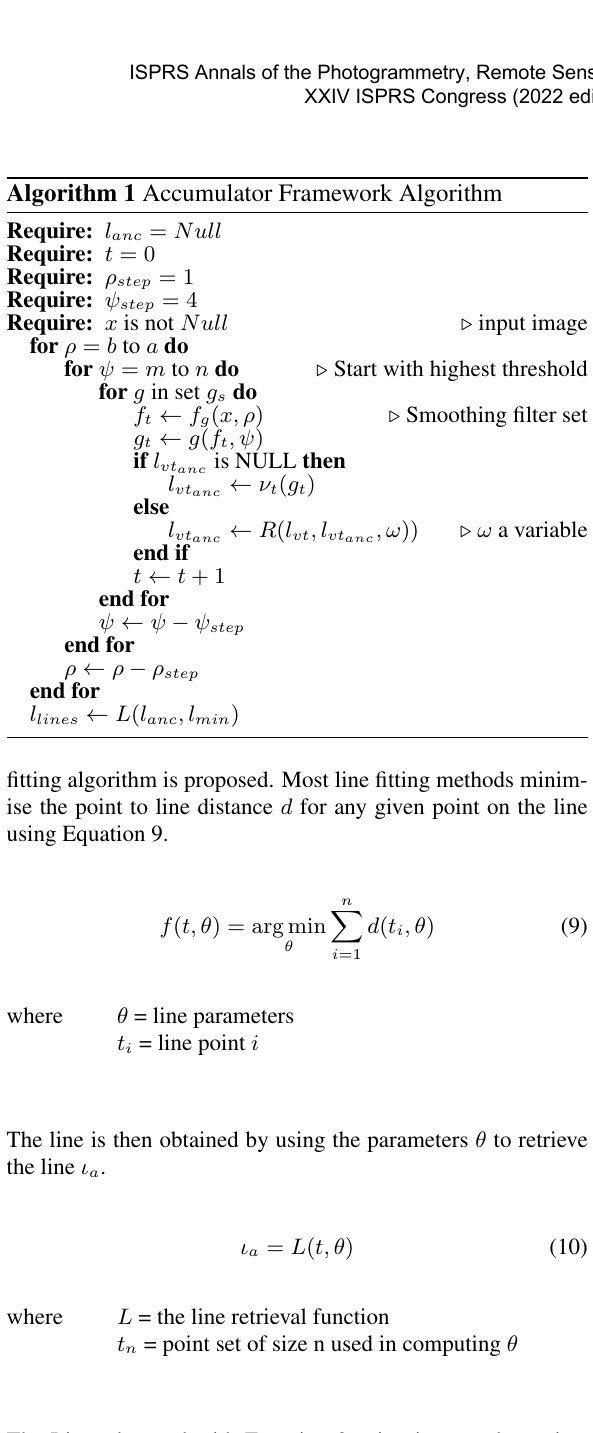
Figure 5. Line fitting with directional error control. Fitting starts from the midsection of the line going outwards maintaining a line direction variation δr that is less than a threshold ϵ at each iteration I m